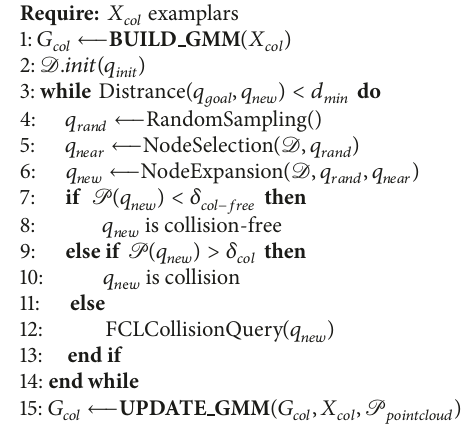
Algorithm 3: GMM-based Motion Planner.